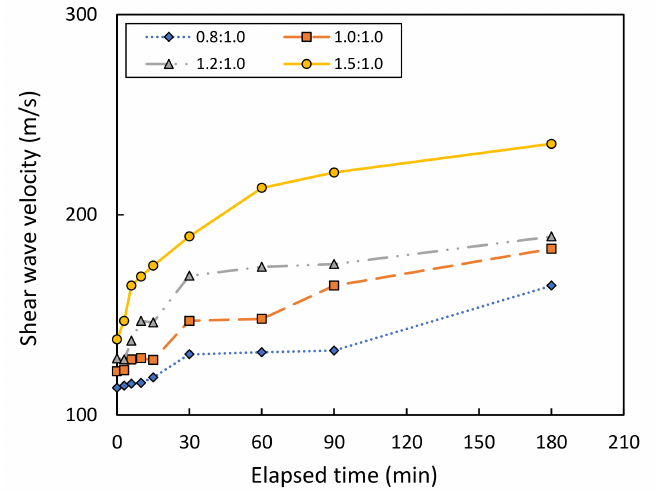
Figure 11. Shear wave velocity vs. the elapsed time of bender element testing for metakaolin treated at 800 ◦ C, using different mixing